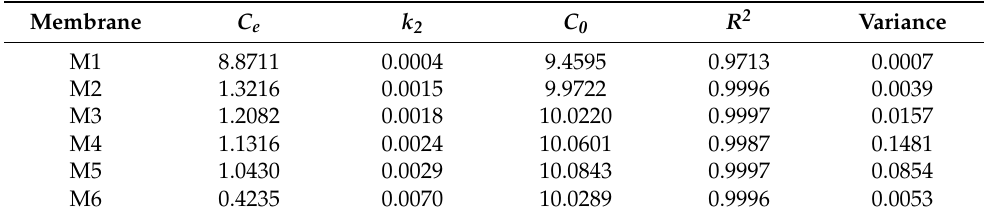
Table 8. Estimated parameter values of the PSO models by the numerical calculations for the extraction process with different percentages of the carrier (B 2 EHP).